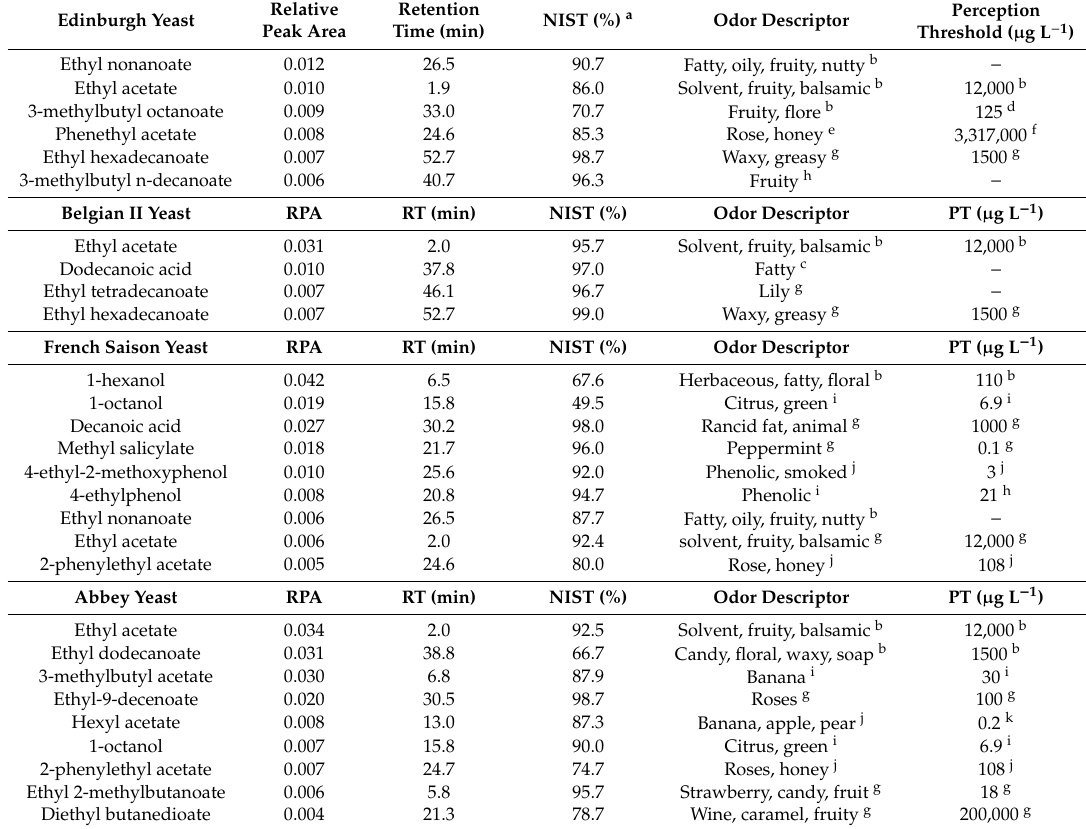
Table 2. Minor ( < 0.05 relative peak area) volatile compounds identified in cider fermented (six months) with the same apple juice and di ff erent S. cerevisiae yeast